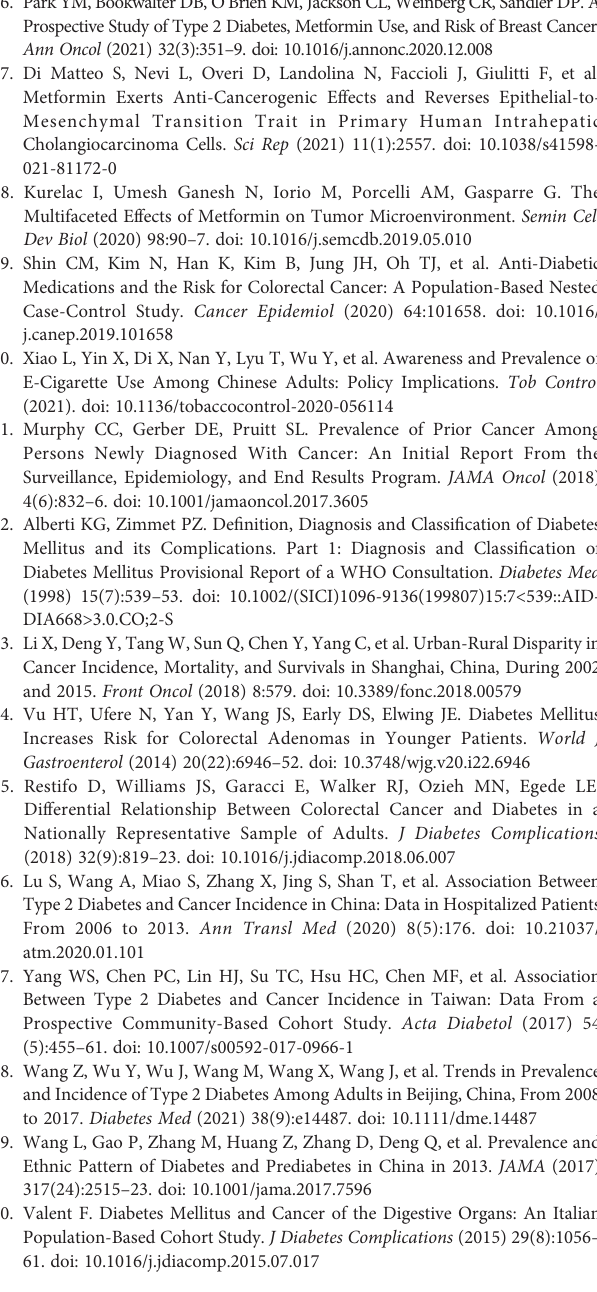
Supplementary Figure 1 | Diagram of this community-based prospective cohort study Supplementary Figure 2 | Age and sex distribution of study